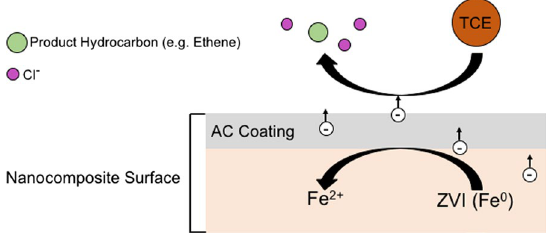
Fig. 2 Schematic diagram of trichloroethene (TCE) degradation via electron shuttling by a generalized AC-ZVI nanocomposite